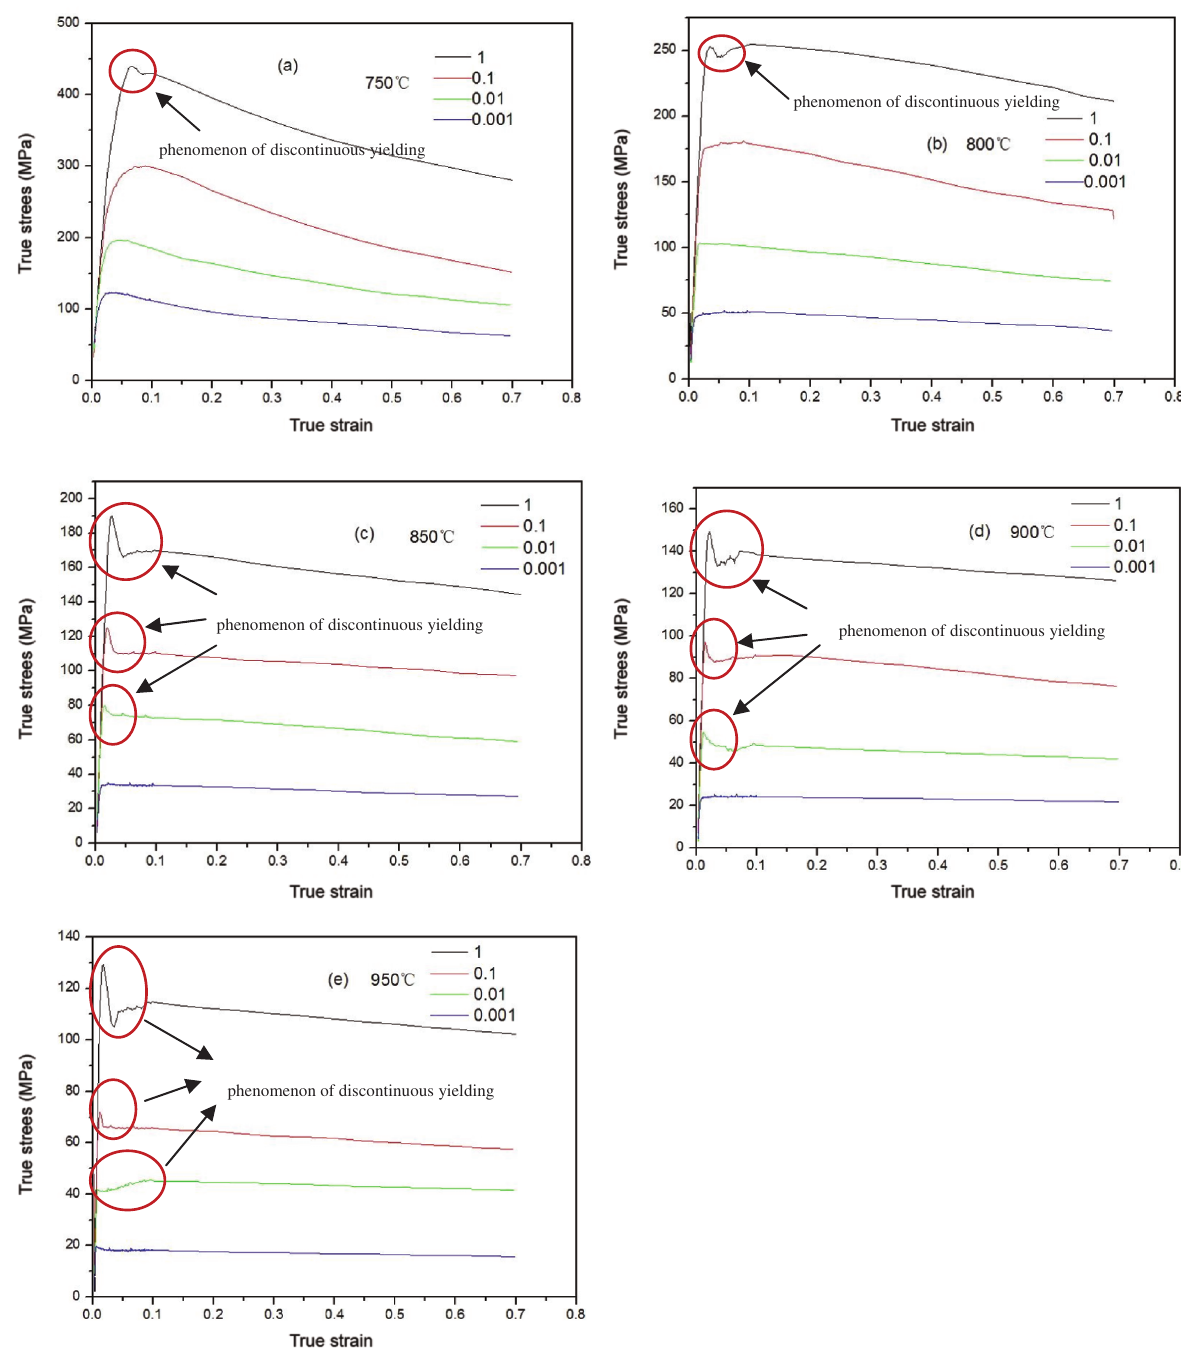
Figure 4: True stress – true strain curves of Ti555211 alloy: (a) 750°C; and (b) 800°C; (c) 850°C; (d) 900°C; (e)